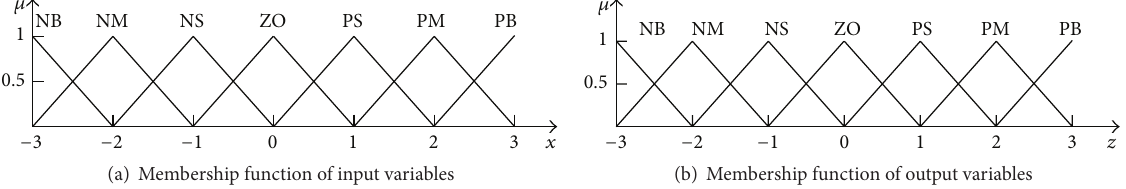
Figure 4: The membership functions of input and output variables.